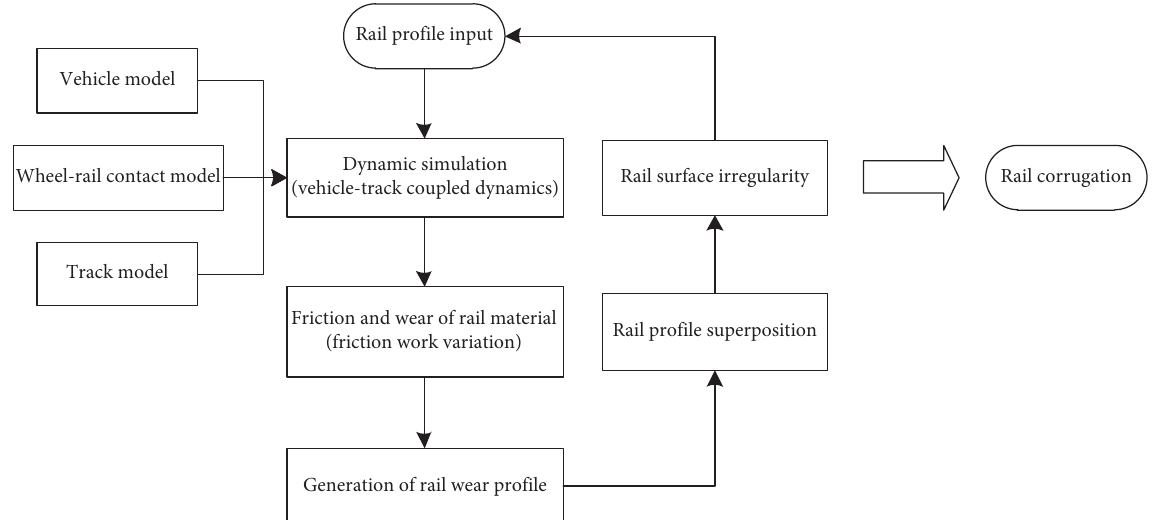
Figure 4: Flow chart of wear superposition calculation.